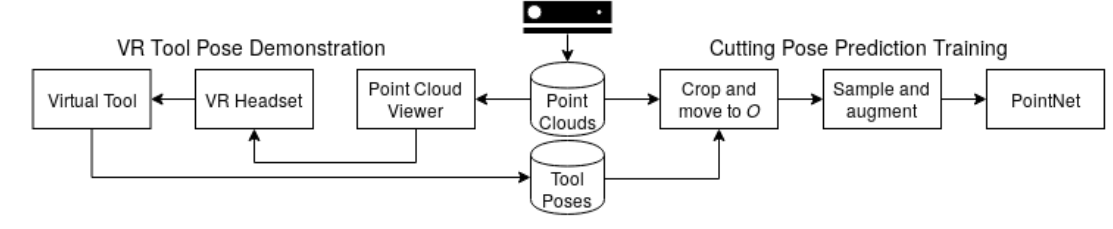
Figure 3. Training system components.